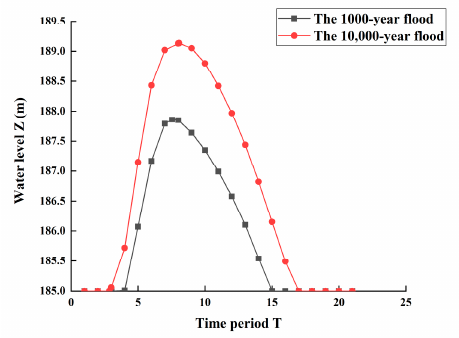
Figure 2. Variation of water level in flood regulation calculation of characteristic floods.